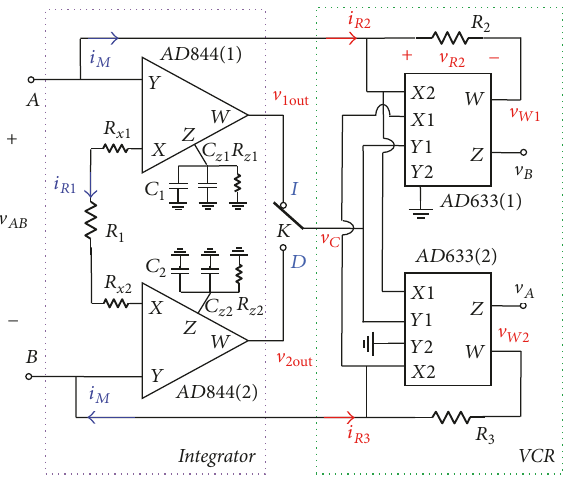
Figure 1: The proposed floating memristor emulator